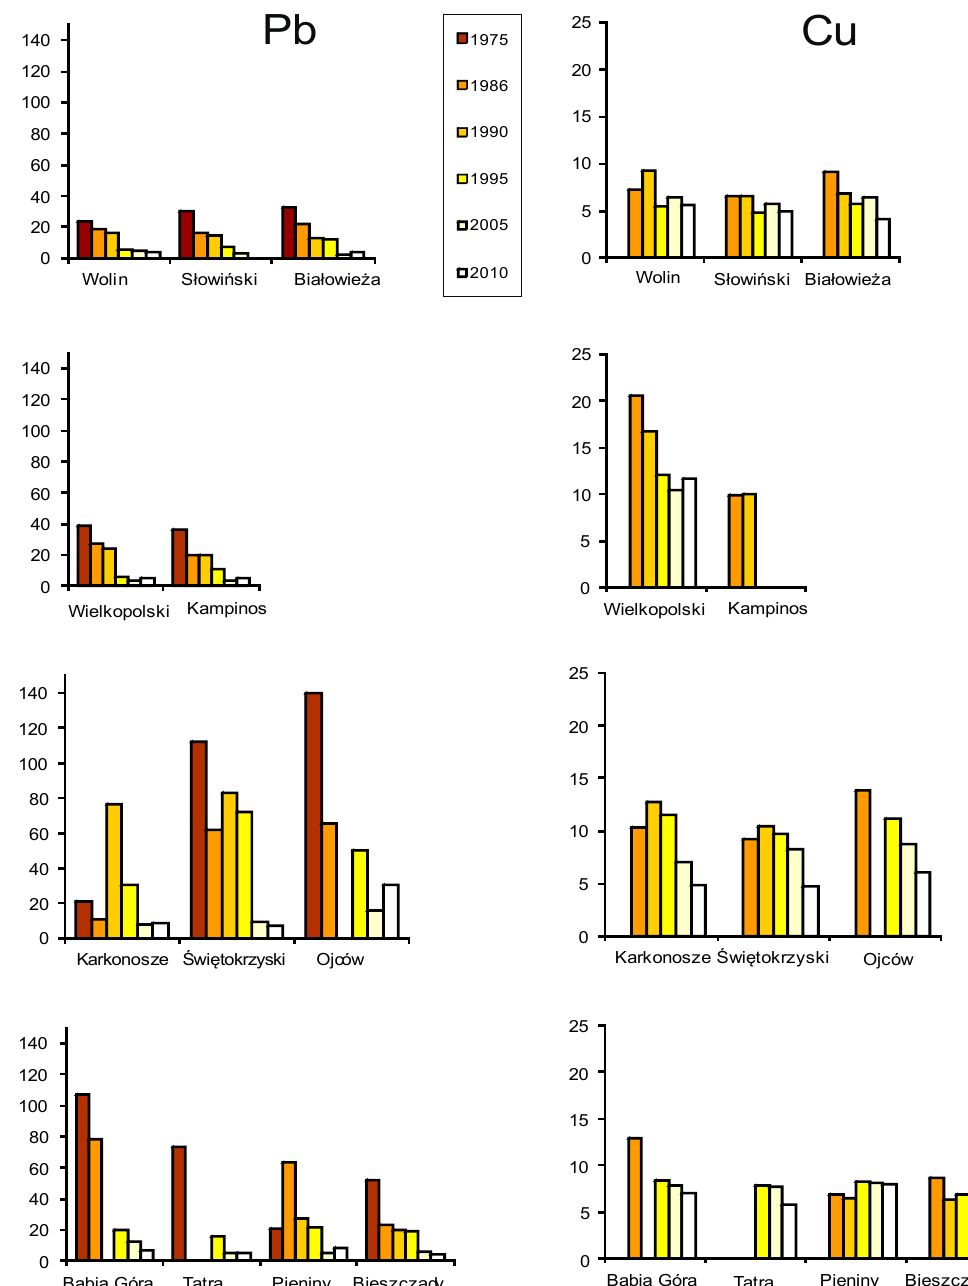
Figure 6. Comparison of average concentrations (mg kg − 1 d. wt.) of lead and copper in Pleurozium schreberi , in 1975–2010, collected in Polish national parks (adapted from [64]). The breakdown of the Chernobyl power plant (at the end of April 1986) coincided with the moss campaign in Polish national parks; therefore, the level of radioactive cesium ( 137 Cs) was also determined in Pleurozium schreberi . The level of 137 Cs ranged from 1832 to 37,814 Bq kg − 1 d. wt. (Figure 7). The smallest contamination was found in the following parks: Wolin, Wielkopolski, Kampinos and Roztocze (1832–3369 Bq kg − 1 d. wt.). Higher cesium concentrations were found in